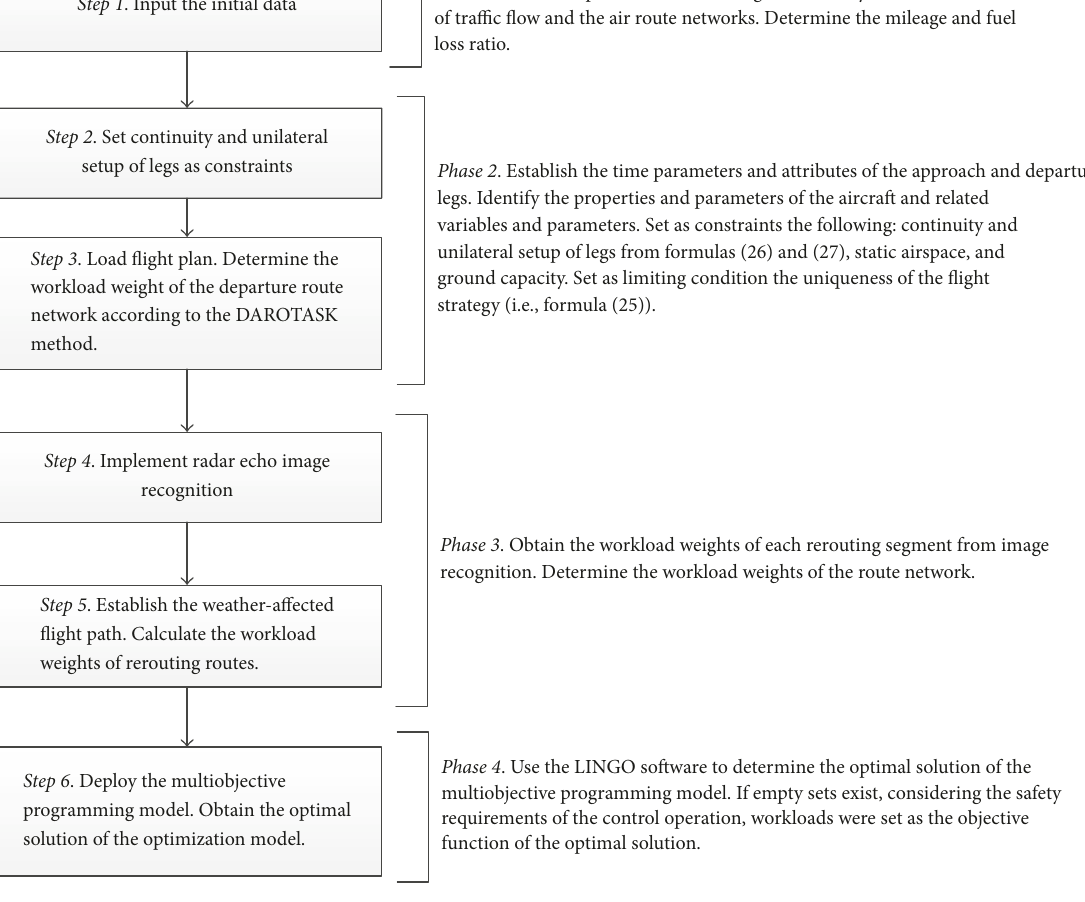
Figure 6: Flowchart of the planning